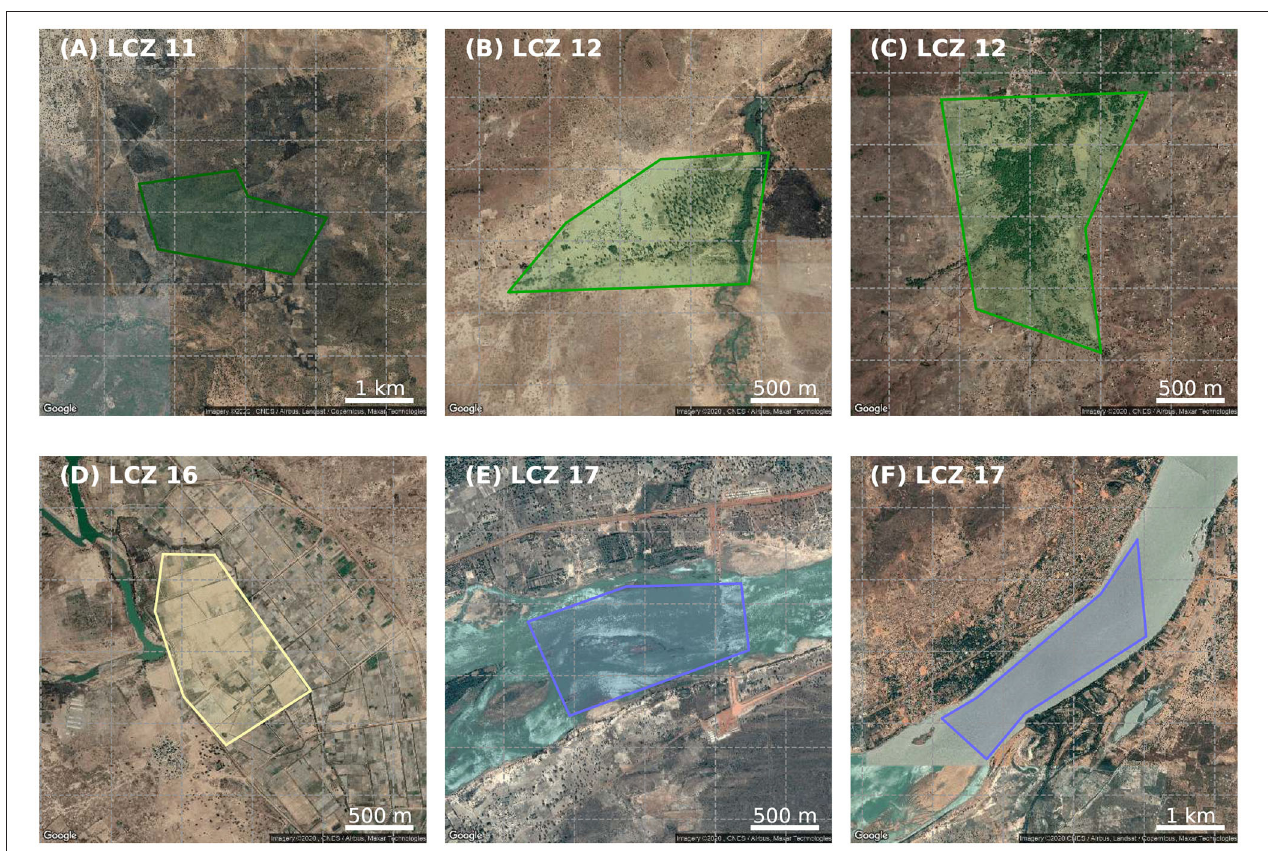
FIGURE 8 | A selection of TA polygons tagged as suspicious during the second quality control step, for Bamako. Color scheme as in Figure 1